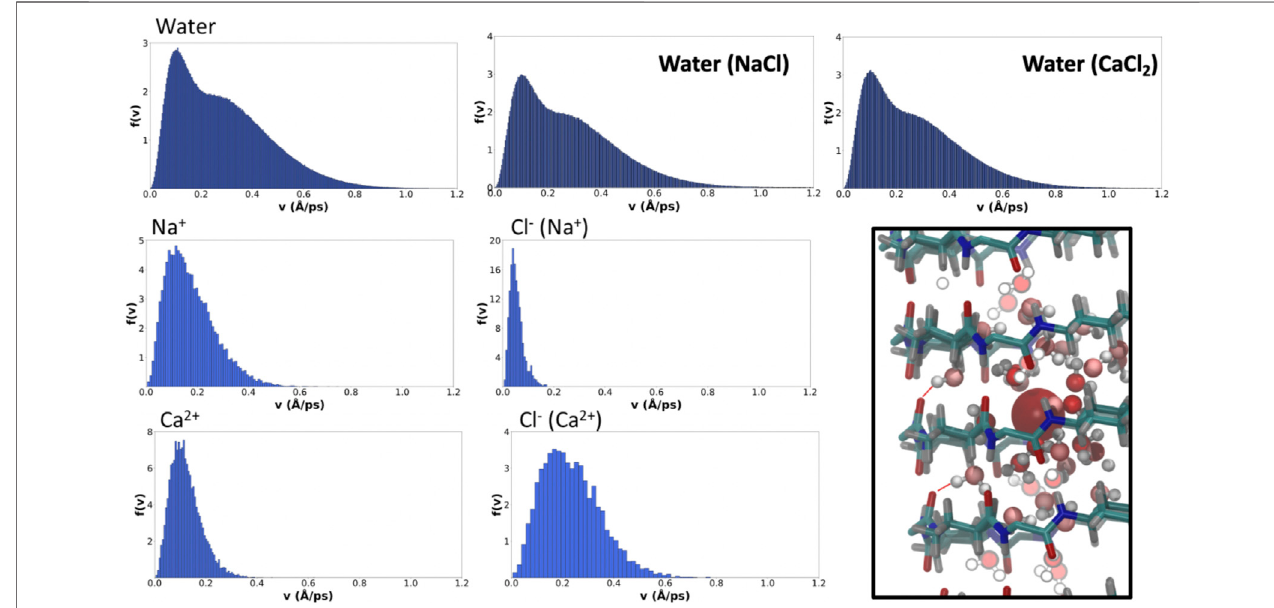
FIGURE 8 | Velocity probability distributions for water (top row, for blank and simulations in the presence of NaCl and CaCl 2 ) and the selected ions. Bin-width has been selected applying the Freedman – Diaconis rule (Freedman and Diaconis, 1981). In the right-bottom square box, a representation of the coordination of Ca 2+ with waters from the fi rst and second coordination spheres is